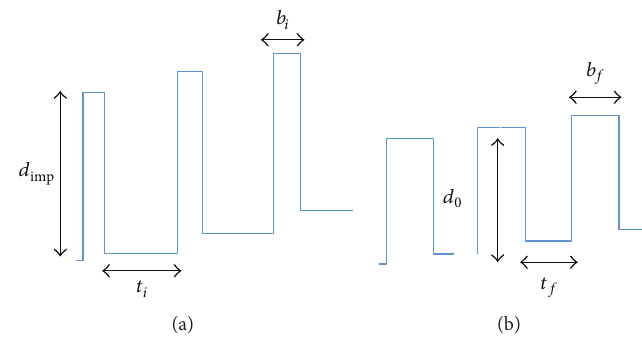
Figure 2: Specific corrugation dimensions. (a) Section (2) of Figure 1. (b) Section (3) of Figure 1.